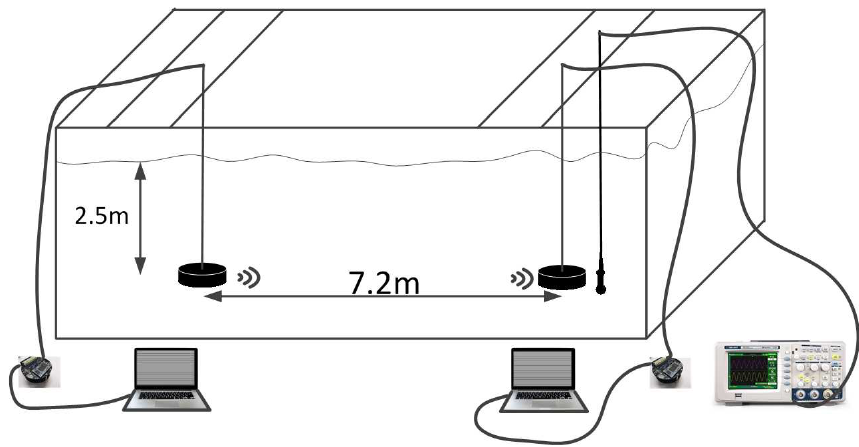
Figure 14. Schematic of the test environment.